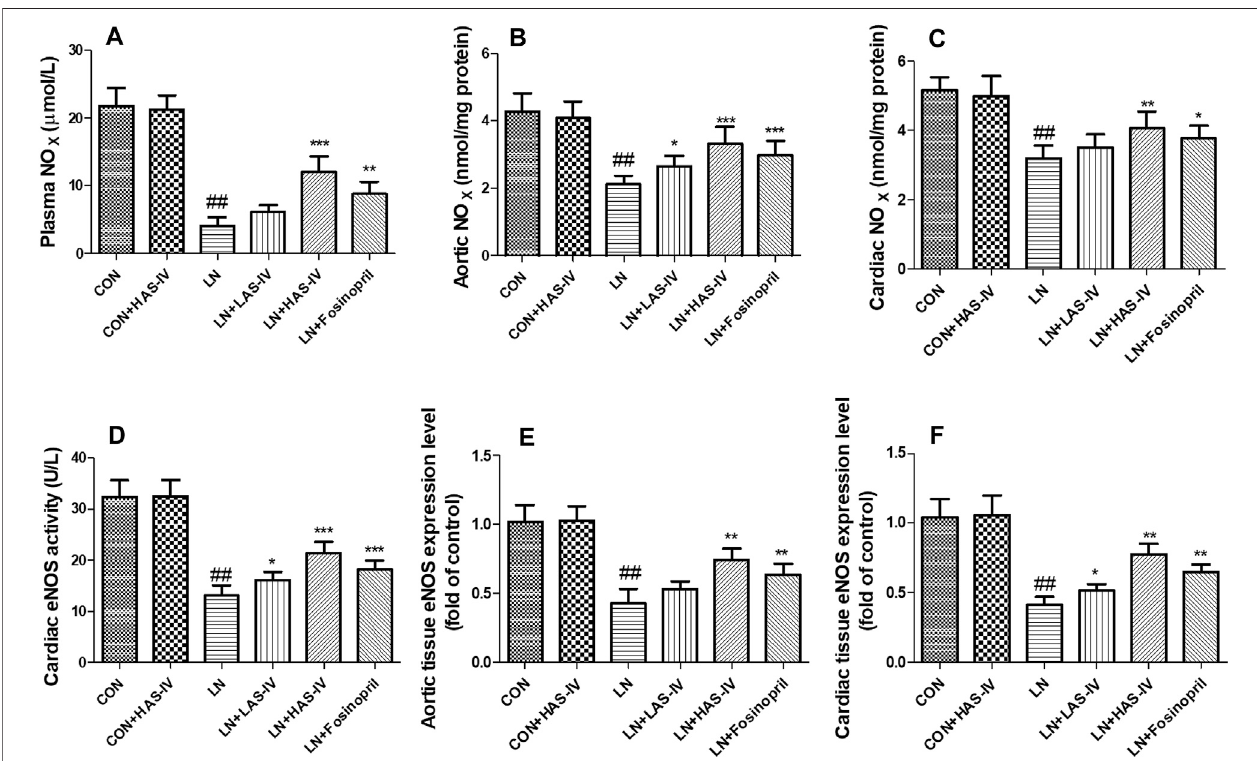
FIGURE7| EffectsofAstragalosideIV(AS-IV)onendothelialdysfunctioninhypertensiveratsevokedbyL-NAME.TheplasmaNO X (A) ,aorticNO X (B) ,cardiacNO X (C) ,cardiaceNOSactivity (D) ,aorticeNOSmRNAexpression (E) ,cardiaceNOSmRNAexpression (F) inCON,CON+HAS-IV,LN,LN+LAS-IV,LN+HAS-IVandLN+ fosinopril groups. Results were showed as mean ± SD ( n (cid:1) 6 for each group). ## p < 0.001 versus CON group, * p < 0.01 versus LN group; ** p < 0.01 versus LN group; *** p < 0.001 versus LN group.